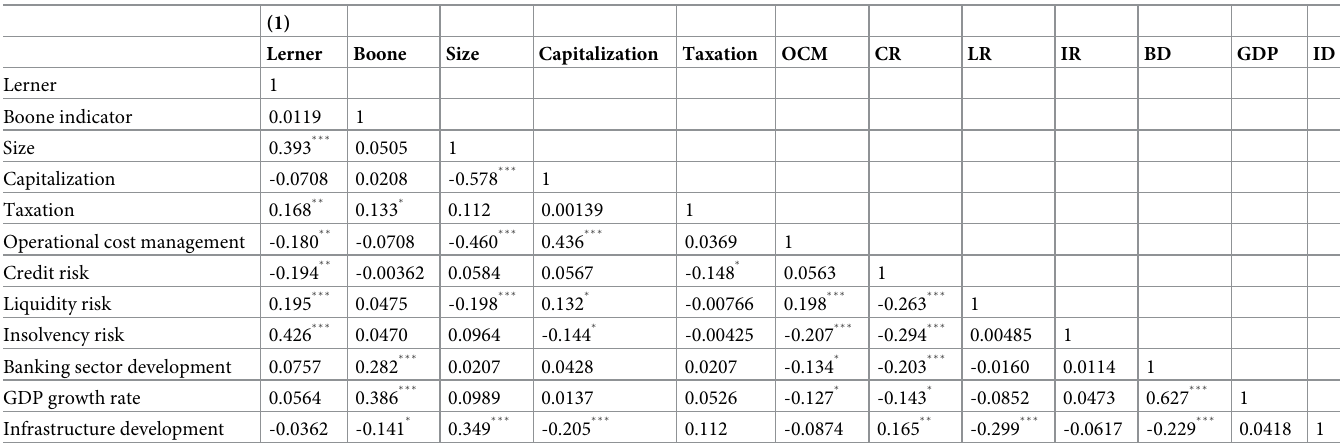
Table 6. Correlation